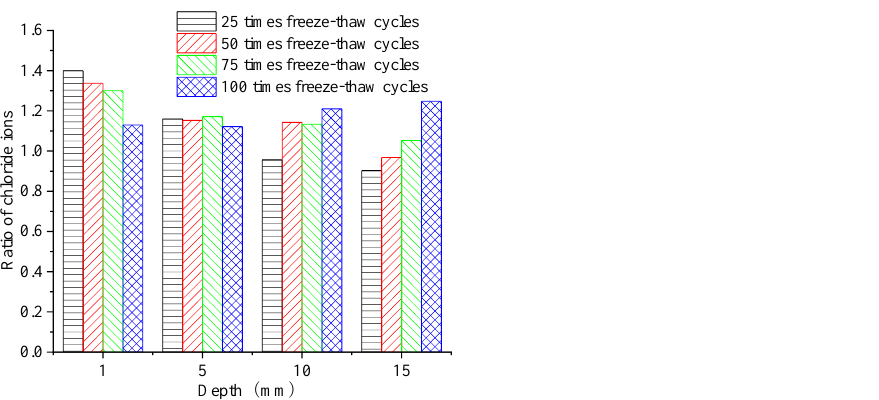
Figure 7. Ratio of the chloride ion concentration at various depths and numbers of freeze – thaw cycles. The absolute value of the CIC at the erosion surface increased with the number of